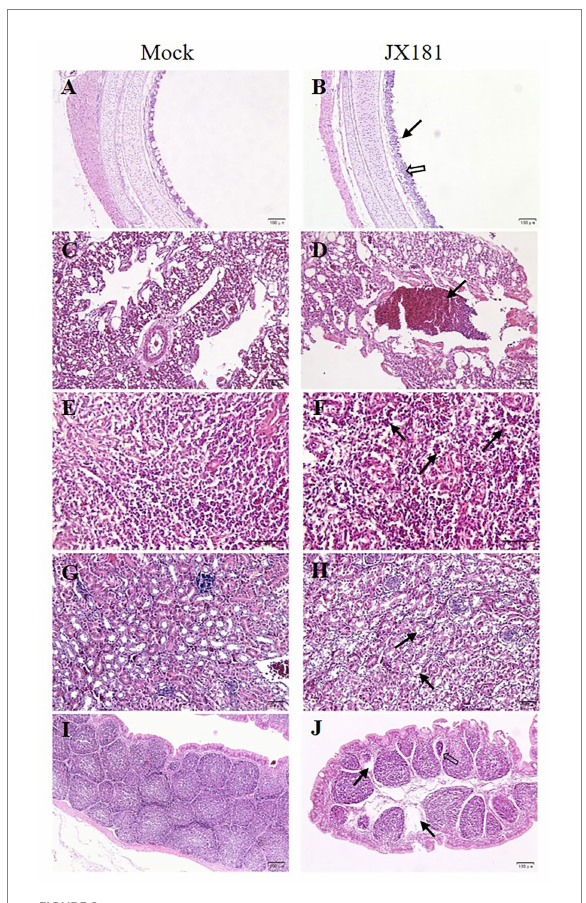
FIGURE 2 Histopathologic changes were observed in different tissues of chicks inoculated with strain JX181 at 6 dpi. (A,B) Trachea: the black arrow indicates the extensive loss and necrosis of ciliated epithelial cells, and the hollow arrow indicates the thickening of the lamina propria of the tracheal mucosa and lymphocyte infiltration. (C,D) Lung: the black arrow indicates erythrocyte infiltration in the bronchial lumen. (E,F) Spleen: black arrows indicate macrophages in the splenic sinus. (G,H) Kidney: black arrows indicate swelling and degeneration of tubular epithelial cells. (I,J) Bursa of Fabricius: the hollow arrow indicates the interstitial dilation of the lymphoid follicles, and black arrows indicate the lymphocyte